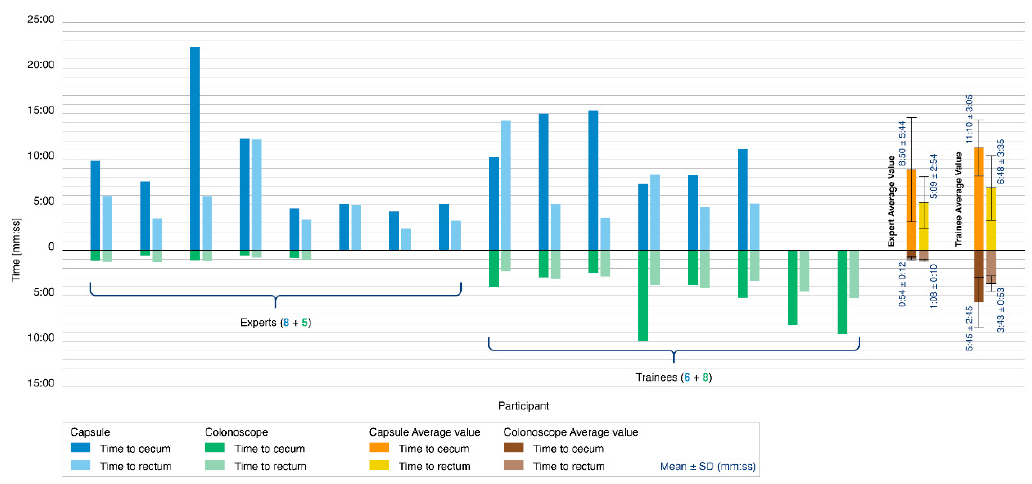
Figure 6. Colonoscopy simulation tests. The histogram reports the comparison between the Endoo system (blue) and the conventional colonoscope (green) in terms of the time taken to reach the cecum (dark blue / green) and time taken to reach the rectum (light blue / green). The tester populations were composed of 5 experts and 8 trainees for the conventional colonoscope and 8 experts and 6 trainees for the Endoo system. Mean times are reported on the right side of the graph.